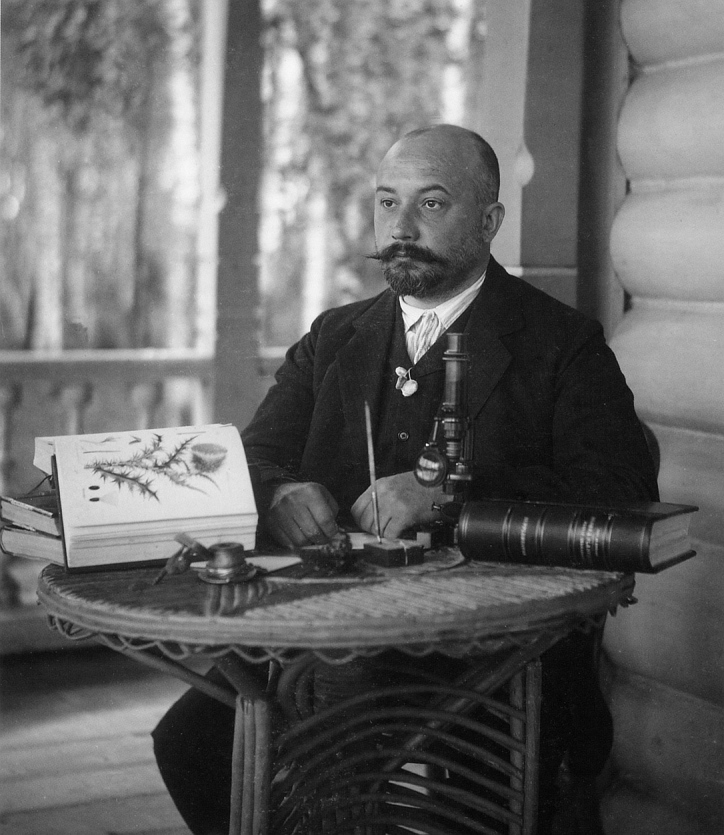
D.P. Syreyshchikov